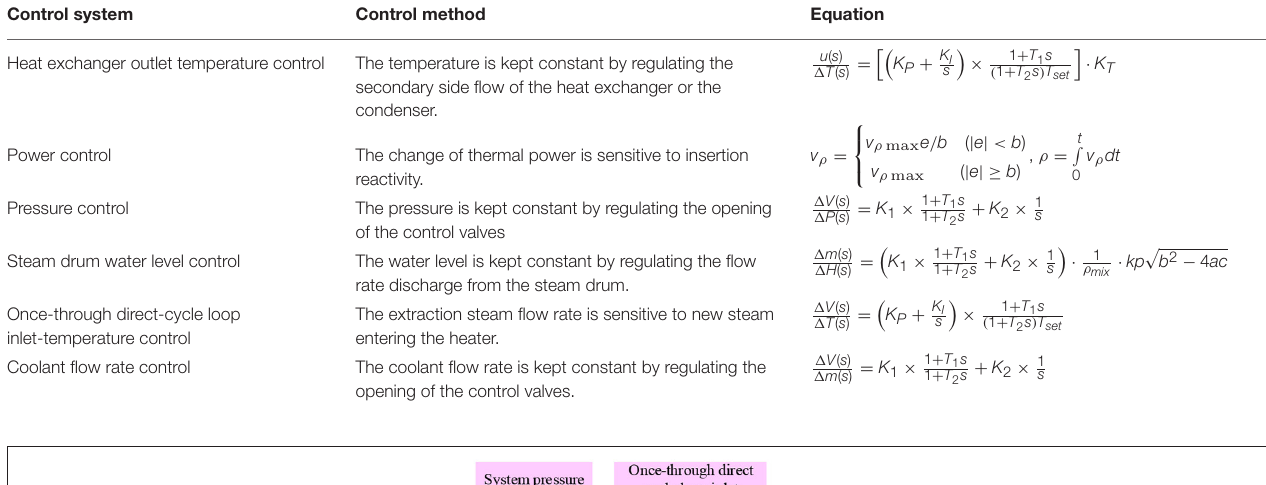
TABLE 3 | SCWR control system.